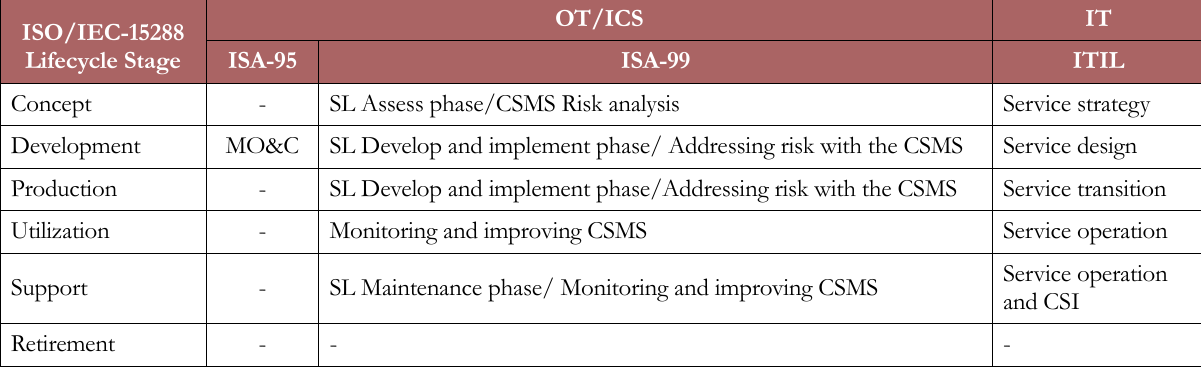
Table 1. Comparison of ISA-95, ISA-99, and ITIL to ISO/IEC-15288 system lifecycle